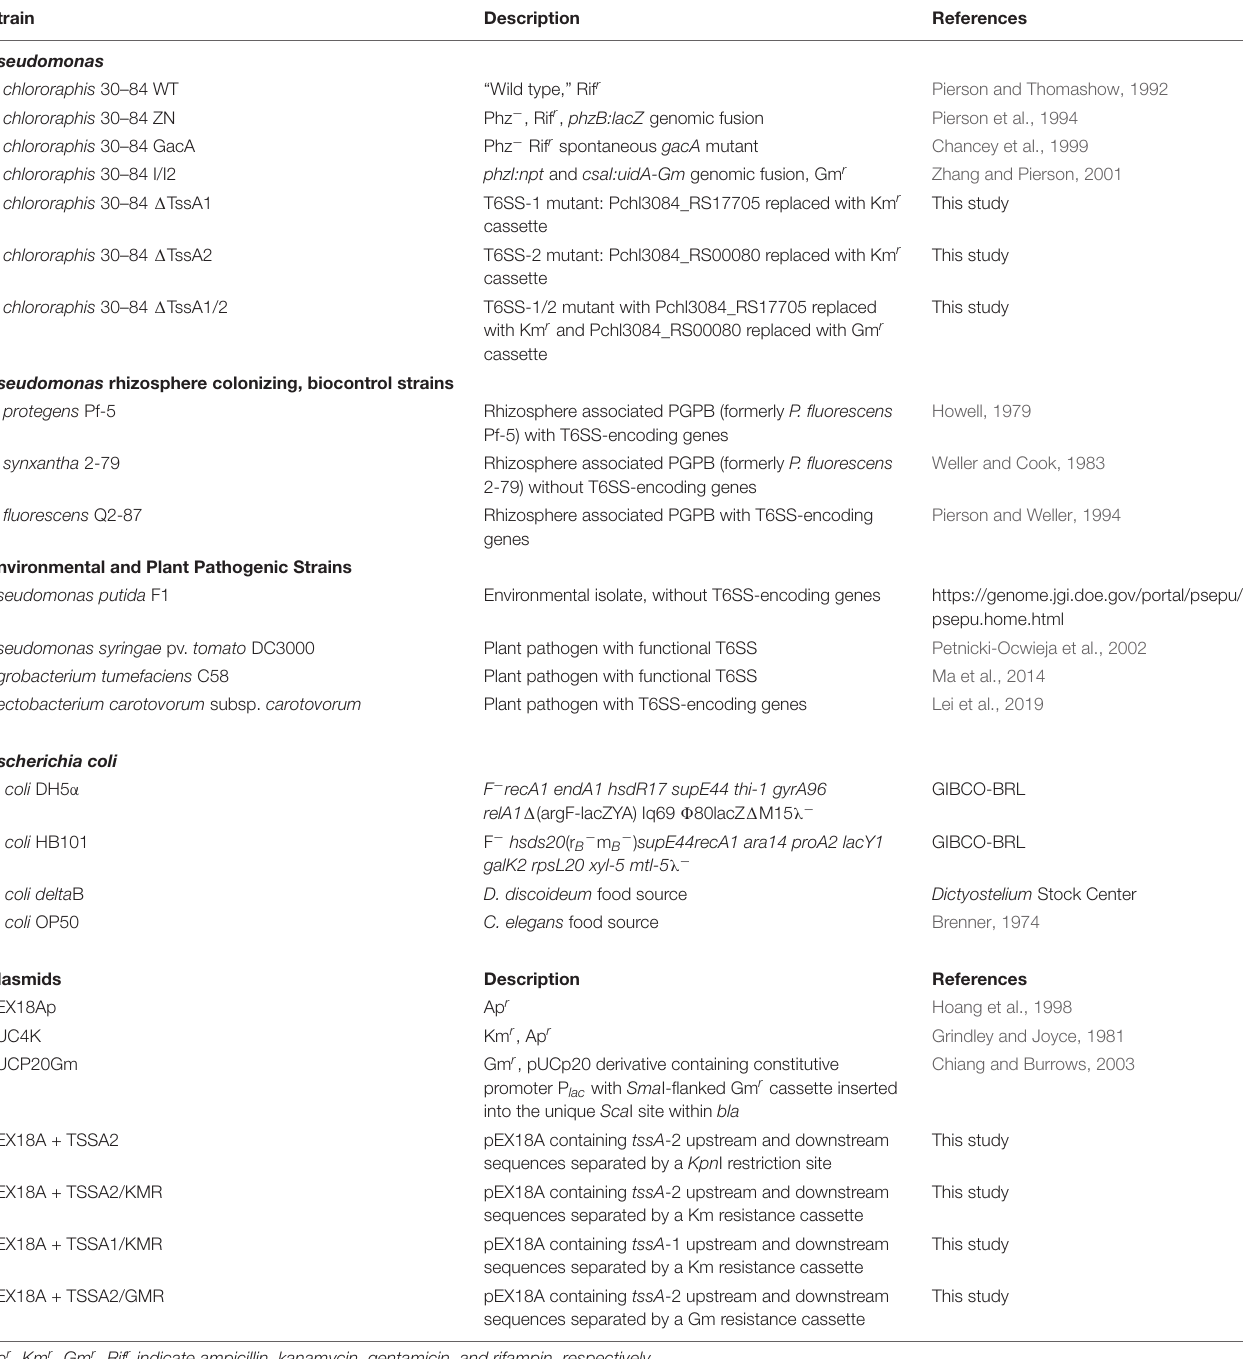
TABLE 1 | Bacteria strains and plasmids used in this study.